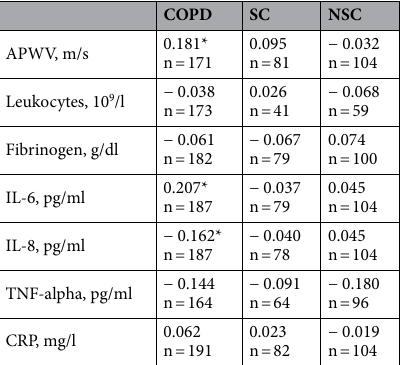
Table 2. Correlations between plasma HA and cardiovascular and inflammatory markers in patients with COPD, smoking controls (SC) and non-smoking controls (NSC). Abbreviations: APWV; arterial pulse wave velocity, CRP; c-reactive protein, IL; interleukin, TNF-alpha; tumor necrosis factor alpha. * p ≤ 0.05.